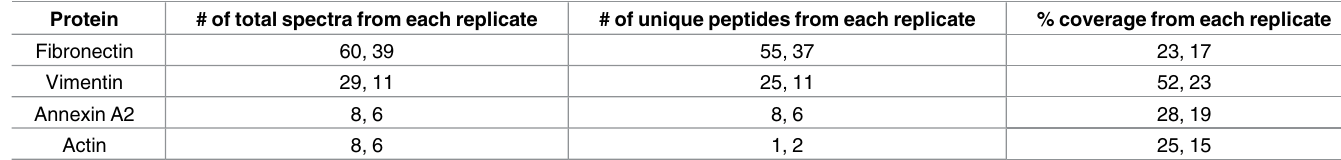
Table 1. List of TM exosomal proteins bound to heparin beads identified by mass-spec in two biological replicates. Protein # of total spectra from each replicate # of unique peptides from each replicate % coverage from each